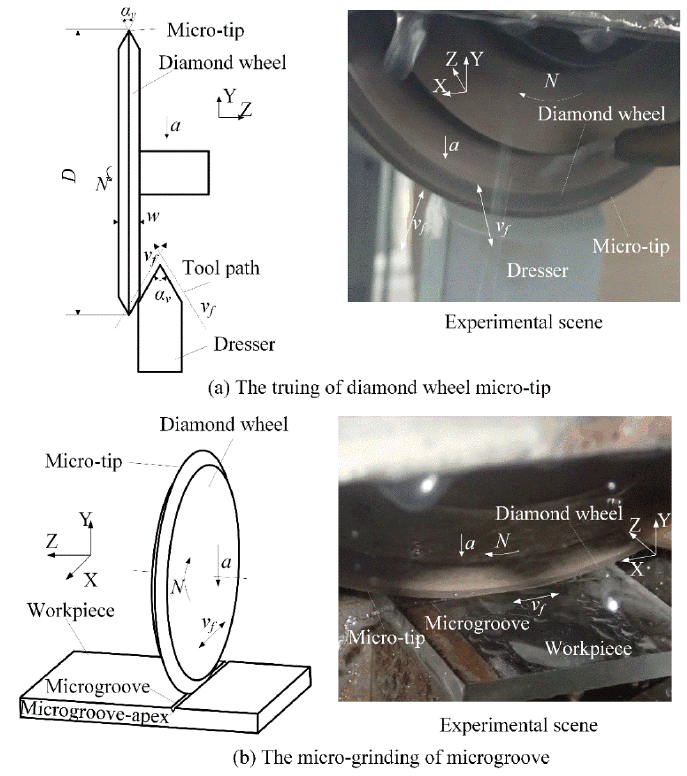
Figure 3. Micro-grinding of microgroove on quartz glass: ( a ) the truing of diamond wheel micro-tip and ( b ) the micro-grinding of microgroove. Table 1. The truing conditions of diamond wheel micro-tip. Table 1. The truing conditions of diamond wheel